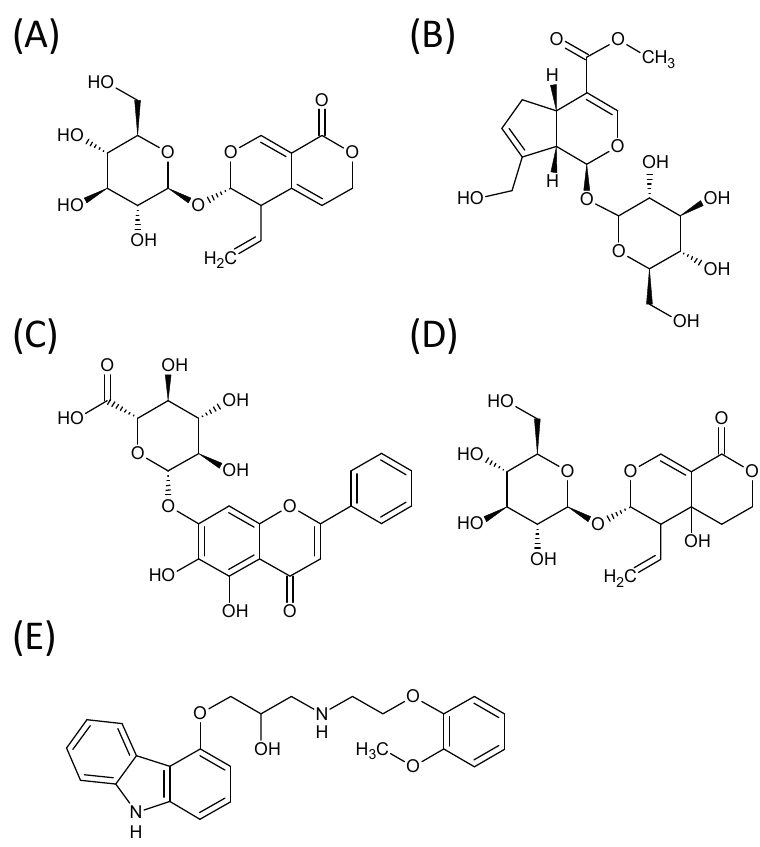
Figure 1. Structure formula of ( A ) gentiopicroside; ( B ) geniposide; ( C ) baicalin; ( D ) swertiamarin; and ( E ) carvedilol